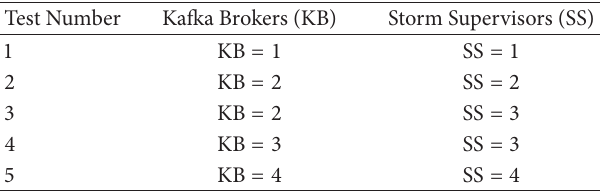
Table 1: The number of Kafka Brokers and Storm Supervisors used in each